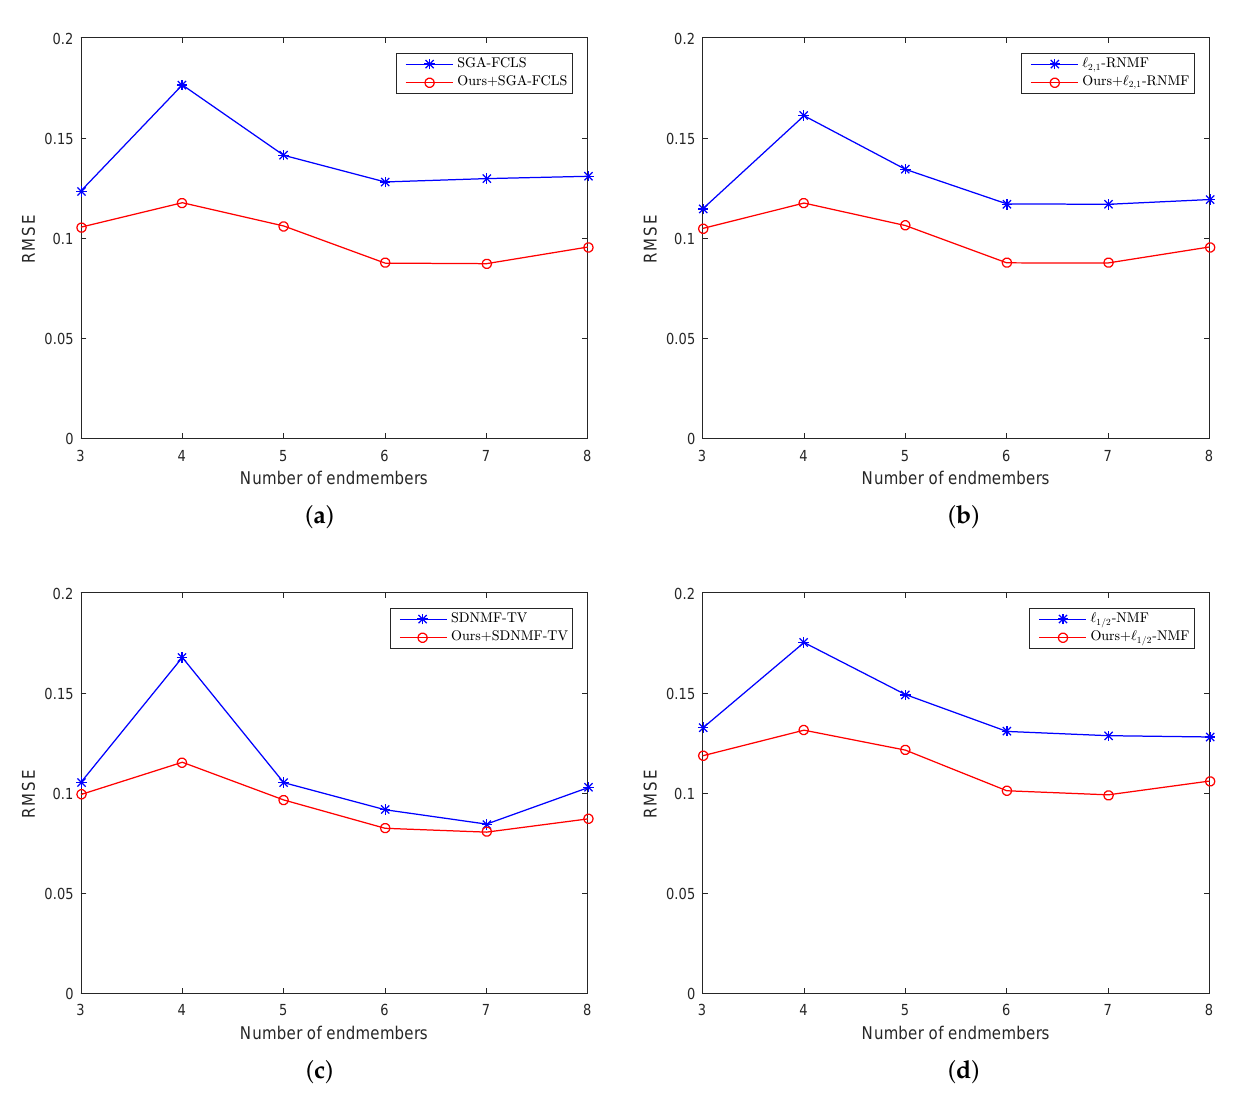
Figure 10. The RMSE results of unmixing algorithms with/without our proposed method when applied to data of different numbers of endmembers. ( a ) SGA-FCLS. ( b ) (cid:96) 2,1 -RNMF. ( c ) SDNMF-TV. ( d ) (cid:96) 1/2